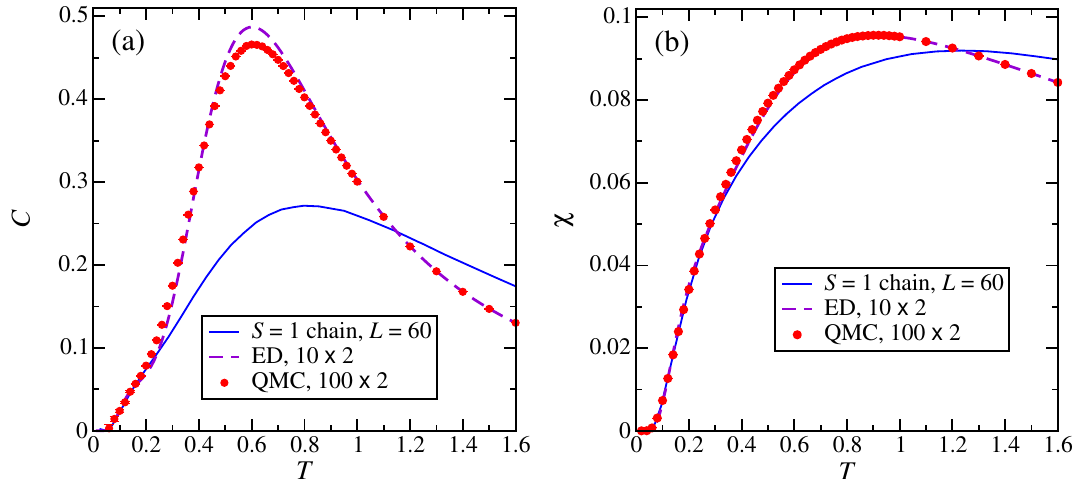
Figure 10: Magnetic specific heat, C , and susceptibility, χ , shown per spin for a partially frustrated ladder with rung coupling J ⊥ = 0.38, leg coupling J (cid:107) = 1, and diagonal coupling J × = 0.9. We compare QMC results obtained for ladders of L = 100 rungs with ED results for L = 10, and with QMC results for a spin-1 chain of L = 60 sites [ 22 ] with J are normalized to twice the number of spins in the